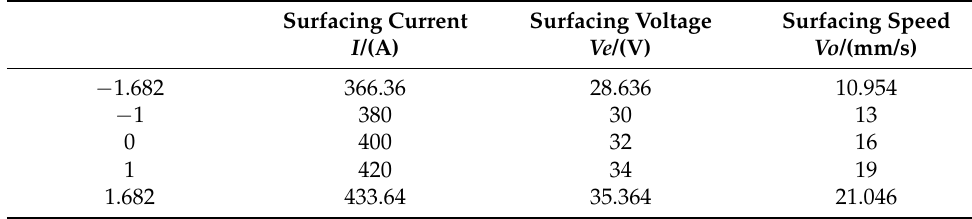
Table 1. Process parameters and their levels.